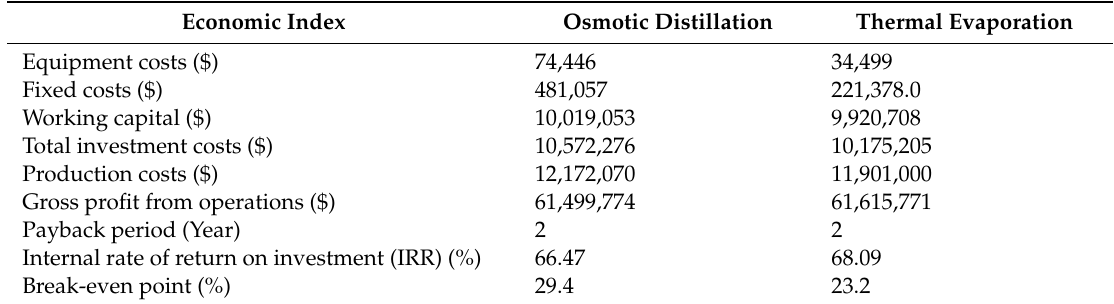
Table 4. Economic analyses of pomegranate juice concentration by OD and thermal evaporation